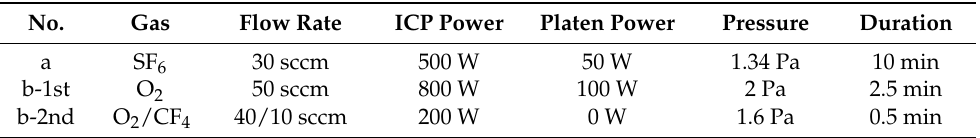
Table 1. Diamond etching process